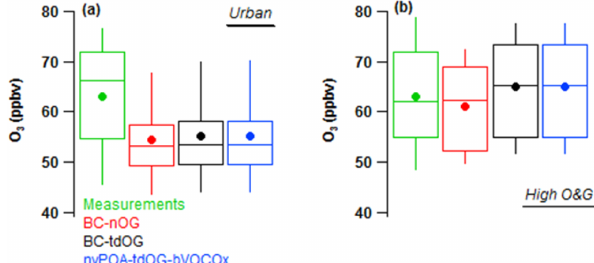
Figure 8. Comparison of the measured and WRF-Chem-predicted mixing ratios of ozone in urban-influenced (a) and high-O&G- influenced (b) plumes. Box and whisker plots depict the 10th, 25th, 50th, 75th, and 90th percentiles. Mean values are shown in